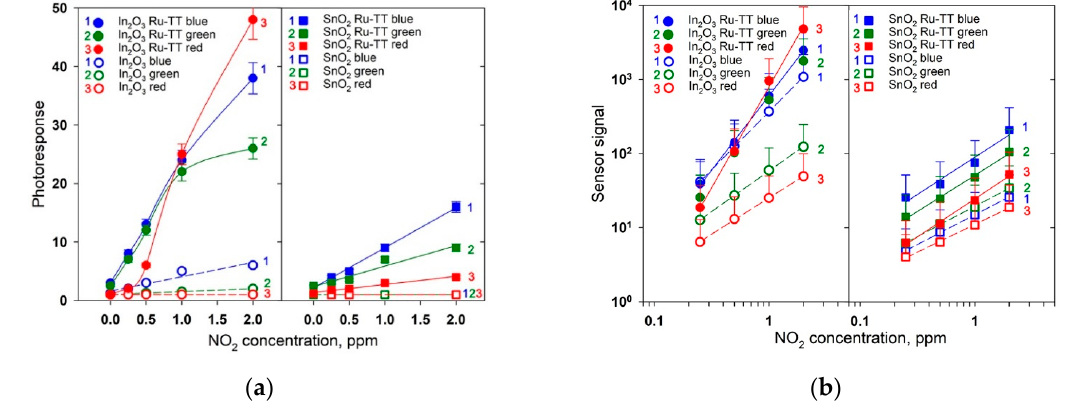
Figure 10. Effective room-temperature photoresponse ( a ) and sensor signal ( b ) of In 2 O 3 - and SnO 2 -based samples under periodic visible light illumination, depending on NO 2 content in the gas phase. Open symbols: data for blank matrixes, filed symbols: data for hybrid materials. (1): blue light ( λ max = 470 nm), (2): green light ( λ max = 535 nm), (3): red light ( λ max = 630 nm).